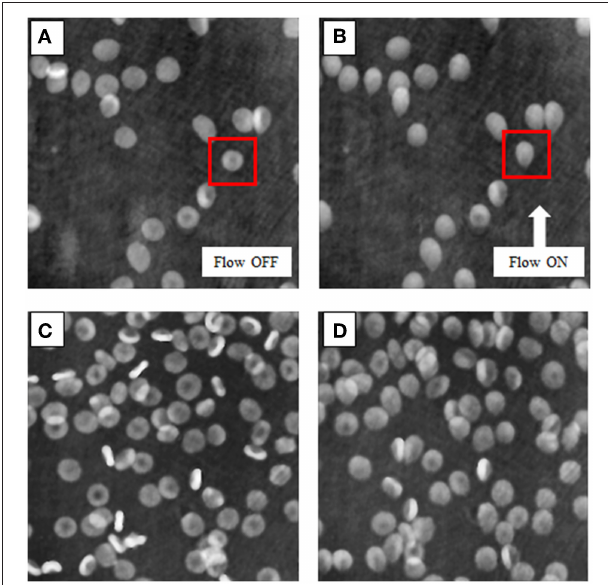
FIGURE 2 | Quantitative phase reconstructions of RBCs. (A,C) report the RBCs before the deformation induced by the flow pressure in the two experimental cases, i.e., with different concentrations, ∼ 10,000/ml and ∼ 50,000/ml, respectively. (B,D) show the effect of the hydrodynamic stress on the RBC membranes when the flow is activated. The red squares highlight the higher shape change in this example (see Supplementary Videos 1, 2 for the entire holographic reconstruction